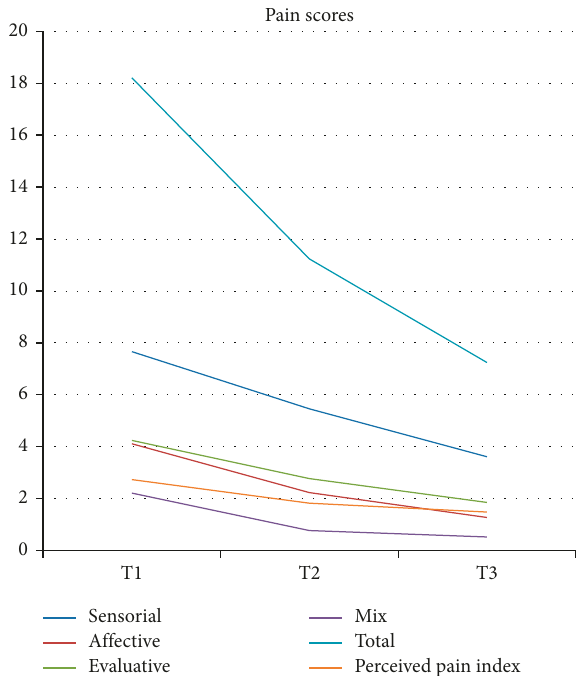
Figure 1: Time changes in pain